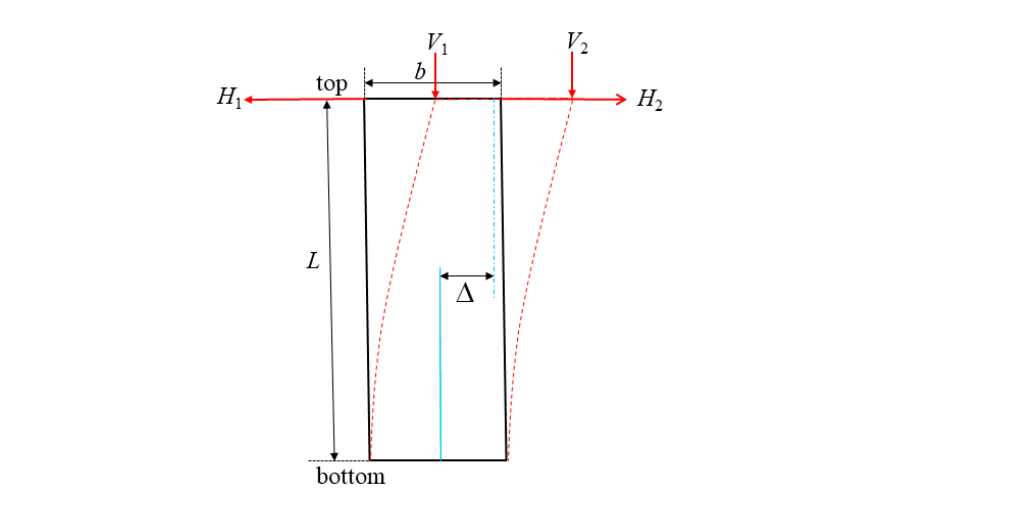
Figure 4. Force diagram of the tower. The parameters L and b are the height and width of the tower respectively. The black vertical solid line and red dot line represent before and after the deformation of the tower. Δ is the horizontal movement value. The parameters V 1 and V 2 are the vertical force. The parameters H 1 and H 2 are the horizontal force. Note that the horizontal force is H 1 ≠ H 2 .